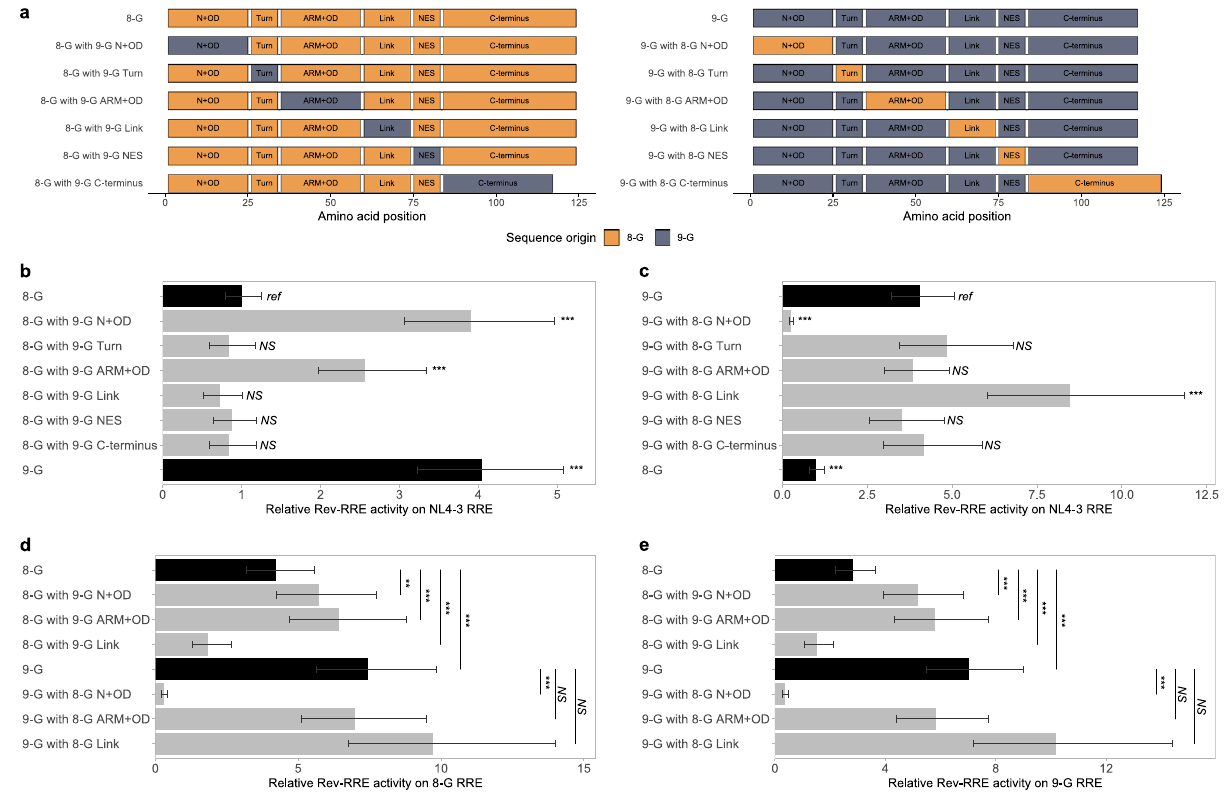
Figure 3. Activity of chimeric Rev sequences. Chimeras of 8-G and 9-G Rev were created by exchanging portions of the sequence corresponding to specific functional domains. A schematic of each Rev construct used in this set of experiments is shown in ( a ). For example, the “8-G with 9-G N + OD” chimera consists of sequence from 8-G Rev except for the functional domains of the N-terminus and first oligomerization domain (corresponding to amino acid positions 1–25) which is taken from 9-G Rev. Functional activity was determined using the fluorescence-based assay system. In each plot, the native 8-G and 9-G Rev sequences are included in dark bars for reference and chimeras are in light bars. ( b ) 8-G chimeras tested on the NL4-3 RRE. ( c ) 9-G chimeras tested on the NL4-3 RRE. ( d ) Selected chimeras tested on the 8-G RRE. ( e ) Selected chimeras tested on the 9-G RRE. For plots b and c, the statistical comparison is performed in reference to the top-most Rev, while in plots d and e the two Revs being compared are indicated by the vertical bar. For all plots, relative activity is expressed in arbitrary units with the activity of the 8-G Rev/NL4-3 RRE pair defined as 1. N ≥ 3 for all data points, error bars represent 95% CI. N + OD—N-terminus plus first portion of the oligomerization domain, ARM + OD—arginine rich motif plus second portion of the oligomerization domain, NES—nuclear export signal. Ref —reference sequence for the plot, NS —not significant, *** p < 0.001, ** p <